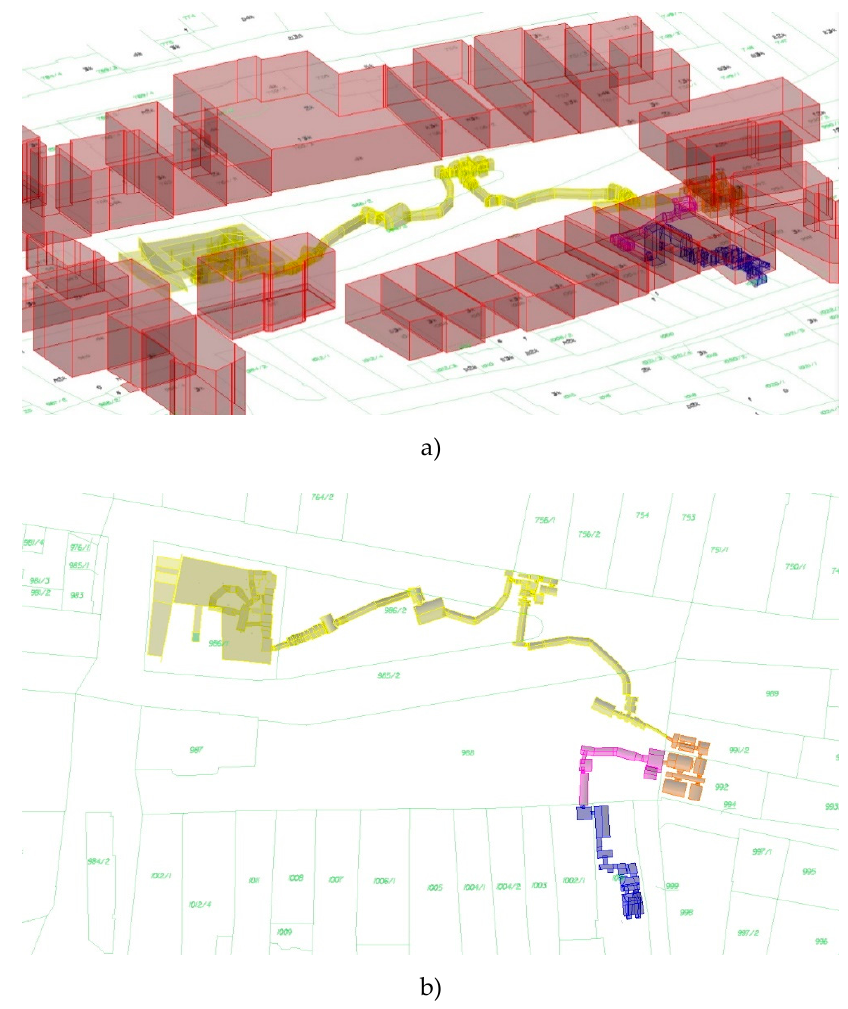
Figure 24. Blocks forming the Underground Tourist Route in Rzesz ó w: ( a ) 3D side view; ( b ) underground objects in 2D